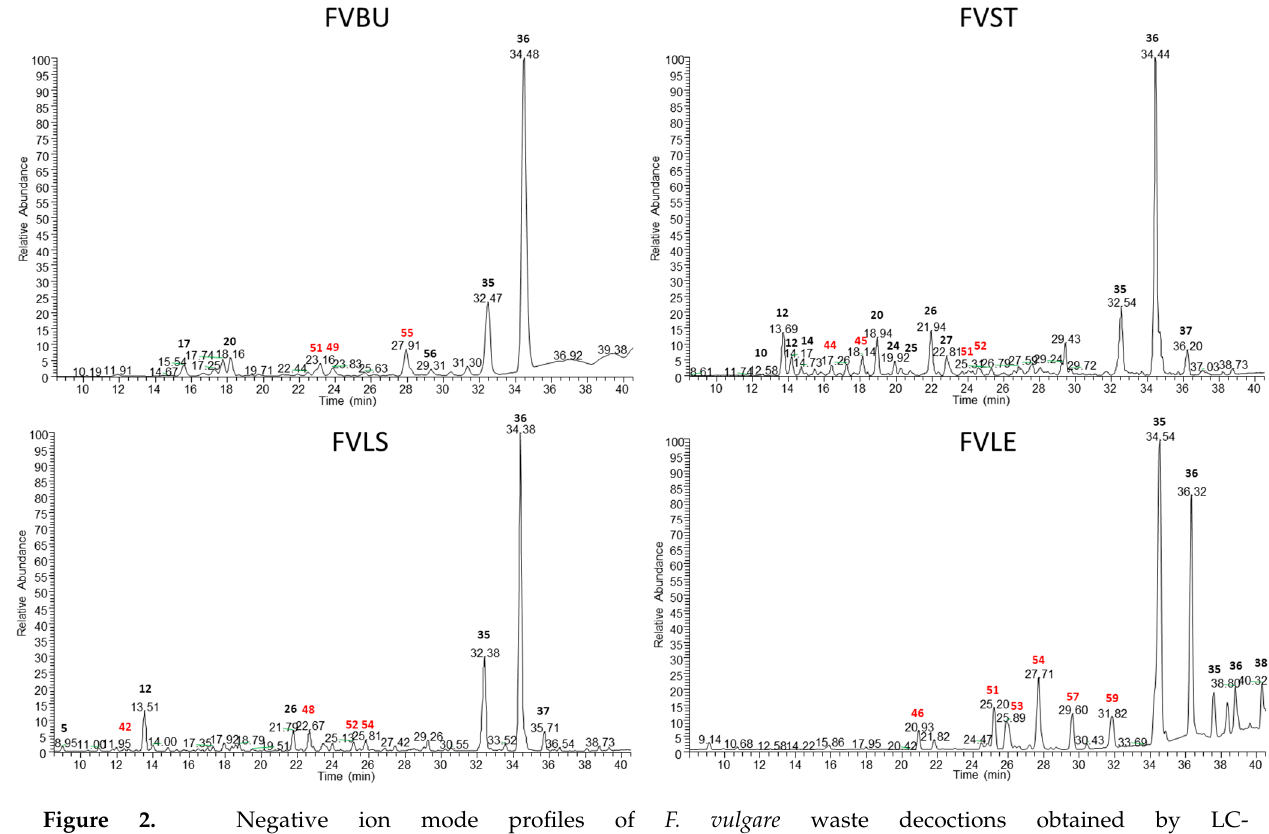
Figure 2. Negative ion mode profiles of F. vulgare waste decoctions obtained by LC- ESI/LTQ/Orbitrap MS: FVBU ( Foenic ‐ ulum vulgare Bulb), FVST ( Foeniculum vulgare Stem), FVLE ( Foeniculum vulgare Leaf) and FVLS ( Foeniculum vulgare Little Stem). The compounds marked in red were identified only in the decoctions and not in the ethanolic extracts.